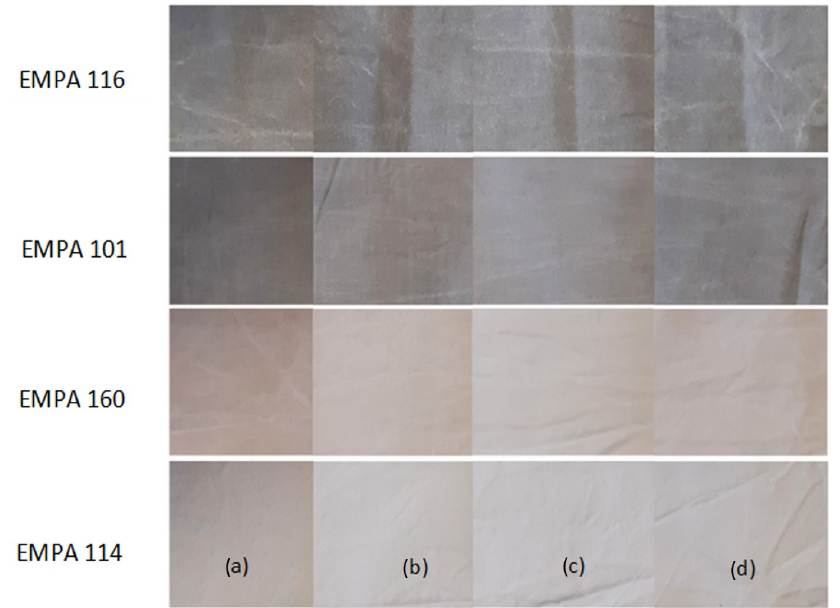
Figure 5. Photos of standard soils after washing without and with the addition of 3% HP in studied wash cycles: ( a ) No HP; ( b ) HP prewash; ( c ) HP main wash; ( d ) HP rinse.